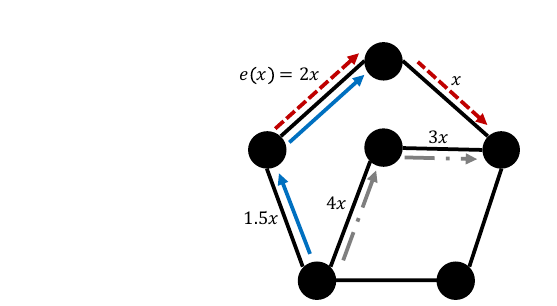
Fig. 2. An Atomic Routing Game With Three